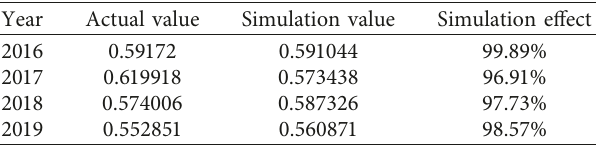
Figure 2: Curve diagram of simulated value and real value of BP neural network test sample. Table 10: GBR simulation